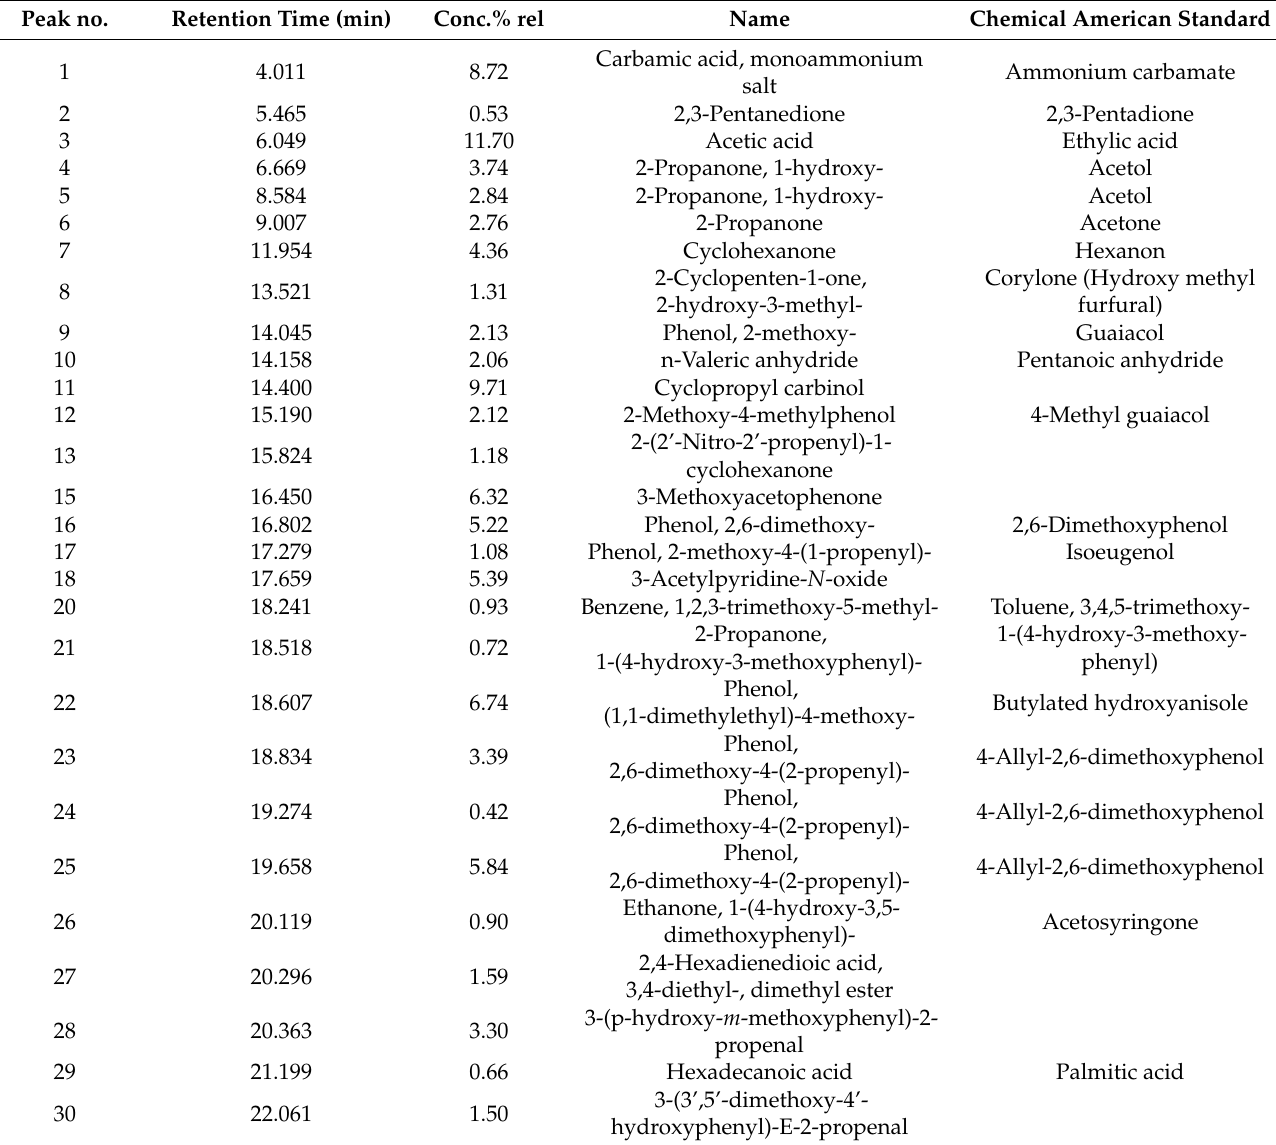
Table 1. Chemical compounds in untreated jabon based on